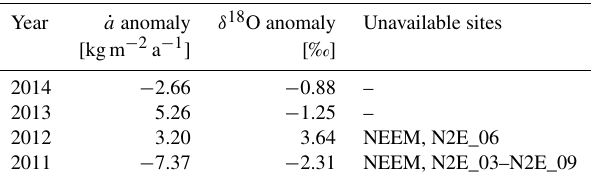
Table 4. Mean deviations of the given year from the average lo- cal annual (winter-to-winter) accumulation rate and δ 18 O. For each year, data from all available sites were used.